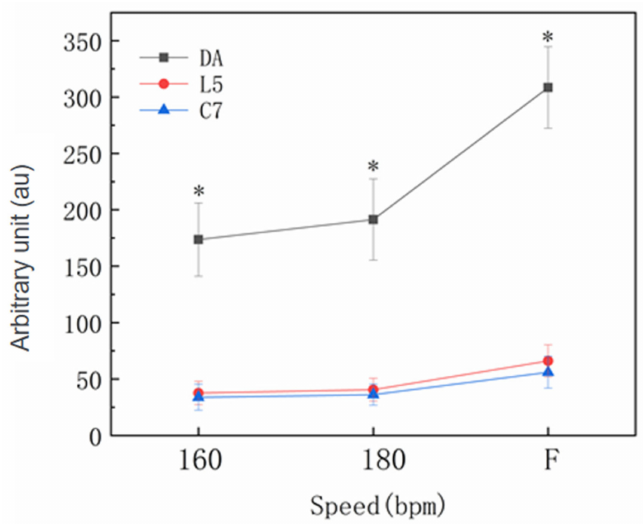
Figure 3. The professional group total PlayerLoad responses to the Zapateado-3 footwork at 160 bpm, 180 bpm and the fastest speed level (F) for the dominant ankle (DA), the fifth lumbar vertebra (L5) and the seventh cervical vertebra (C7). * Denotes a significant main effect for the unit position.